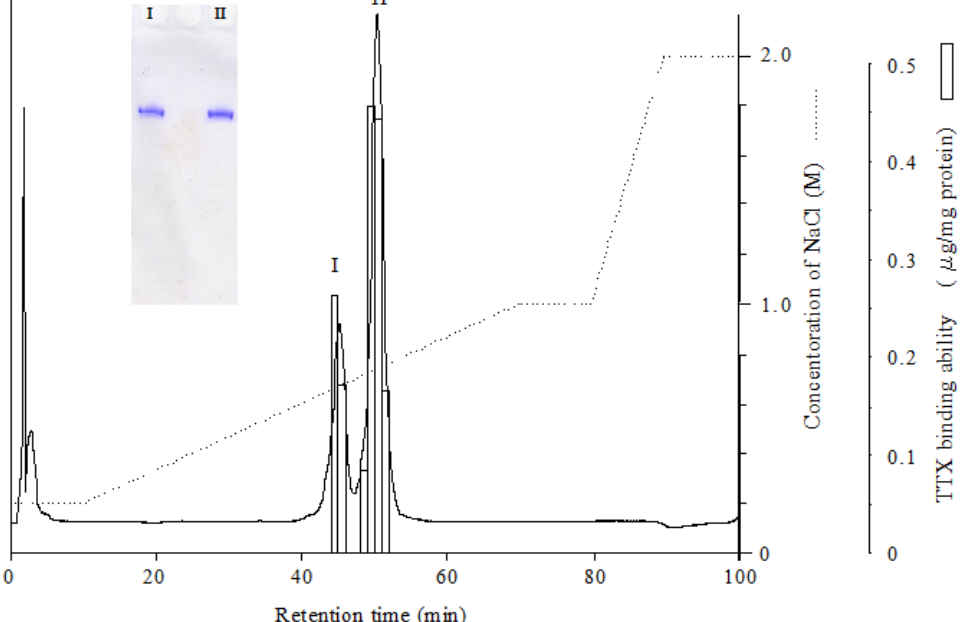
Figure 1. MonoQ anion-exchange HPLC of active fraction obtained from preparative electrophore- sis. Sample: active fraction obtained from preparative electrophoresis; column: MonoQ5/50 GL (0.5 × 5 cm); mobile phase: 0.2–2.0 M NaCl-0.01 M sodium phosphate buffer (pH 7.4); flow rate: 0.5 mL/min; detection: absorbance at 280 nm; inlet: Native-PAGE; I; peak I obtained from Mono Q an- ion-exchange HPLC, II; peak II obtained from MonoQ anion-exchange HPLC.